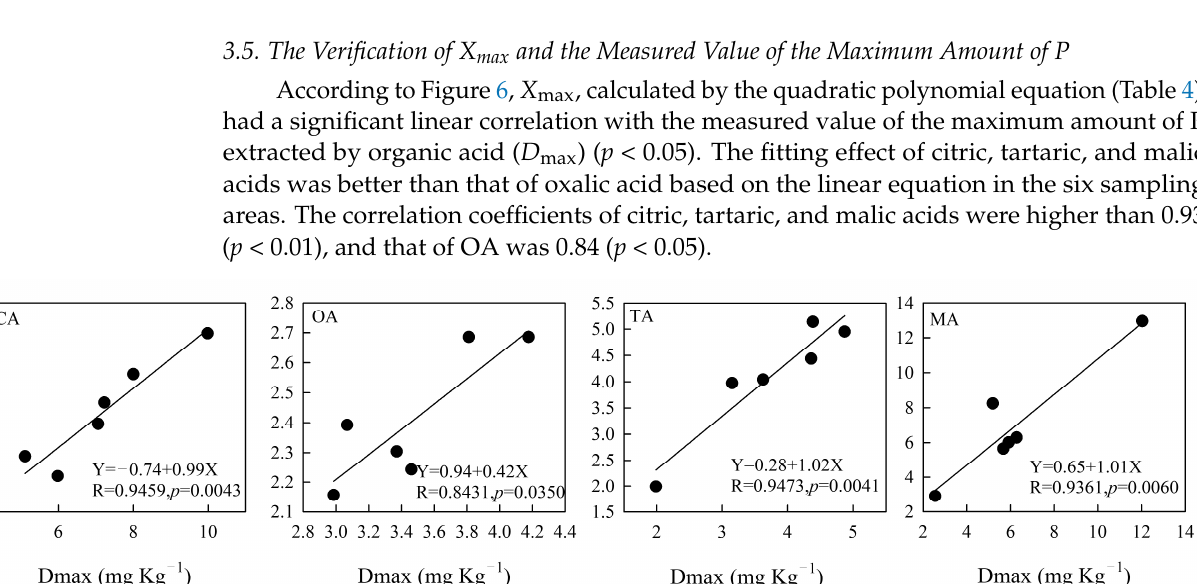
Figure 6. The correlation of X max and the maximum P concentration extracted by different organic acids. Note: X max is the maximum amount of P extraction shown in Table 4. D max is the measured value of the maximum amount of P selected among eight concentrations of LMWOAs. The maximum P was extracted when the concentration of CA and OA was 8 mmol L − 1 and that of TA and MA was 20 mmol L − 1 . S1, S2, S3, S4, S5 and S6 are six sampling areas.